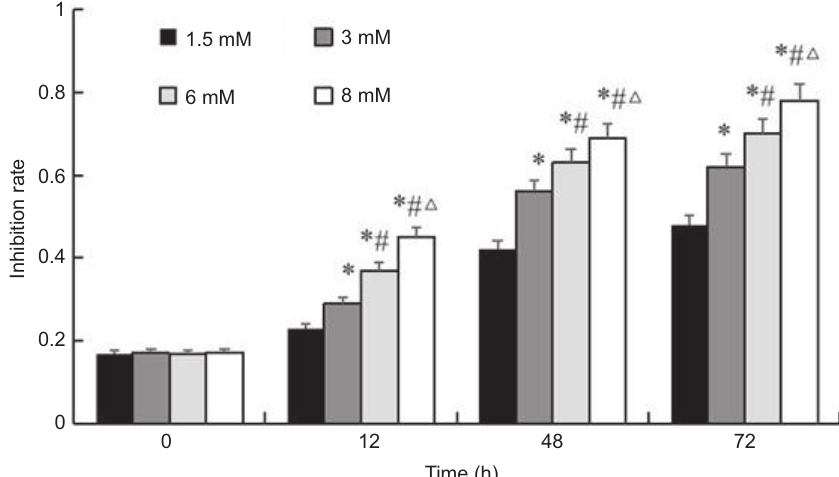
Figure 1: The growth inhibition effect of ligustrazine on A498 cells by MTT assay. The cells were treatment with ligustrazine at each concentration for 24, 48 and 72